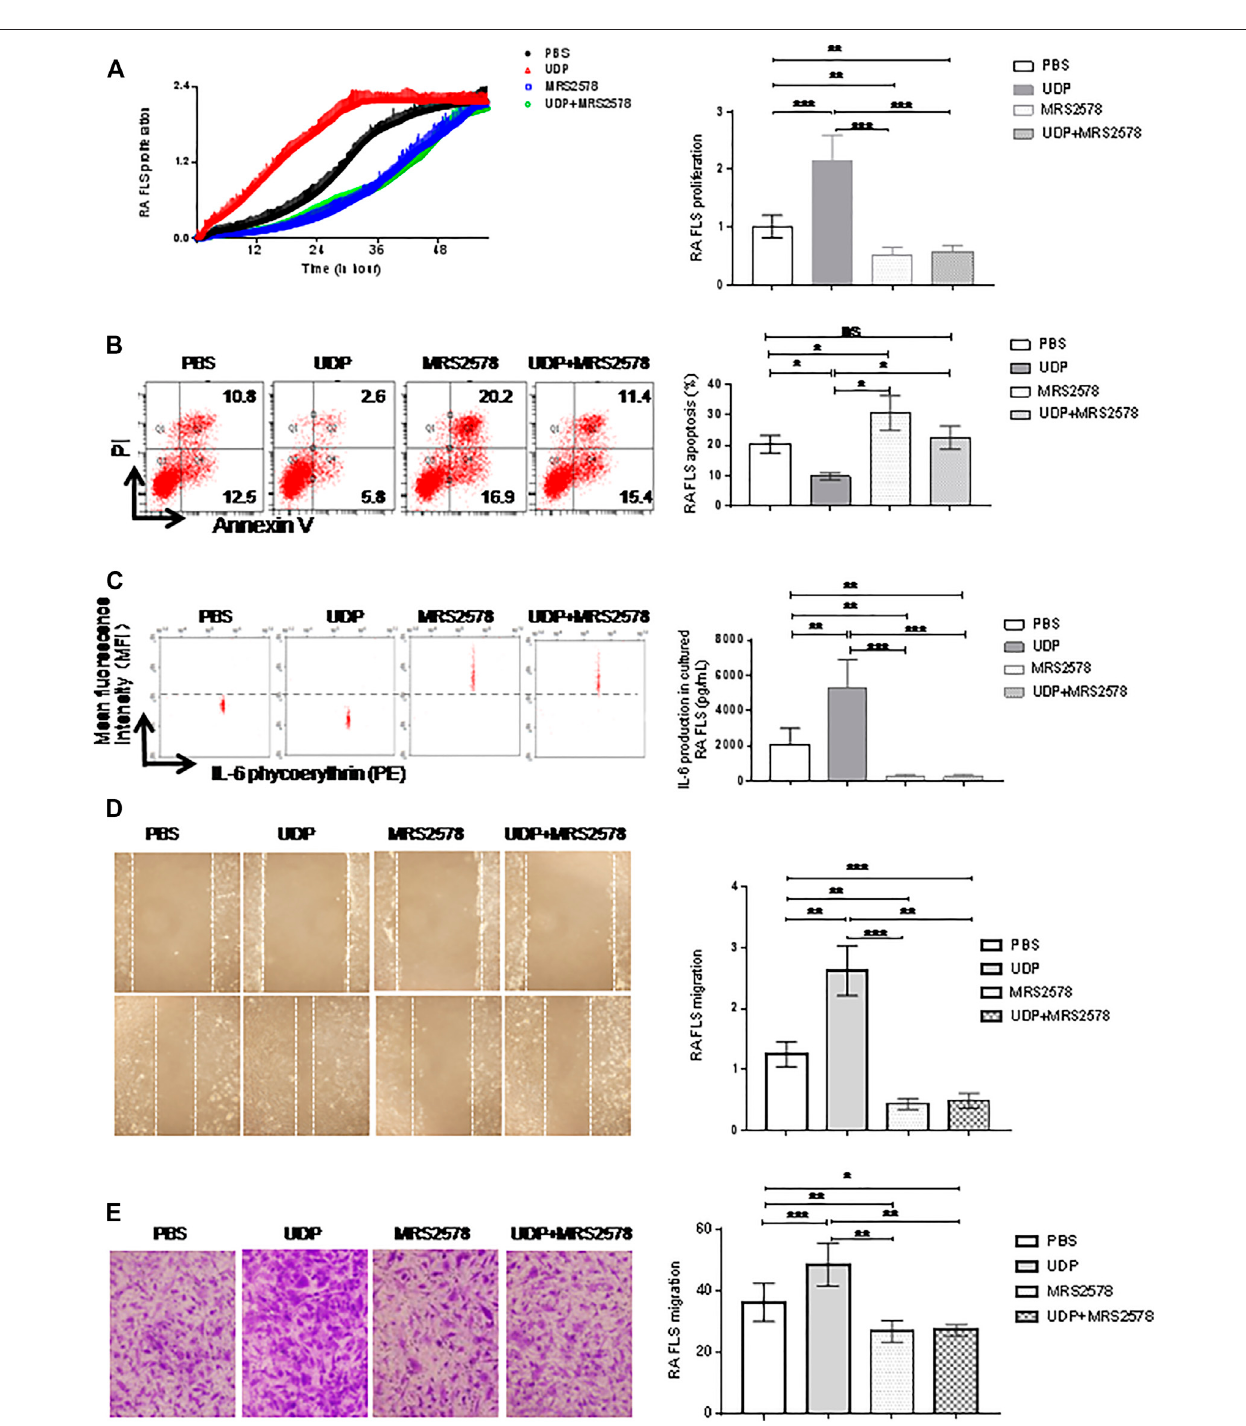
FIGURE6| The Effect ofMRS2578oncellactivitiesand IL-6production incultured synovial fi broblastcells. Thecultured synovial fi broblast cellsofRA( n (cid:1) 5) were treated with UDP (100 μ M) and/or MRS2578 (10 μ M). (A) Cell proliferation was assessed using RTCA and statistical analysis. (B) Apoptosis was assessed using fl ow cytometry and statistical analysis. (C) IL-6 secretion was assessed using a fl ow cytometric bead assay and statistical analysis. (D) Cell migration was assessed using a wound healing assay and statistical analysis. (E) Cell migration was assessed using a Transwell assay and statistical analysis. These experiments were repeated three times. * FLS: synovial fi broblast cells. * p < 0.05, ** p < 0.01 and *** p < 0.001.